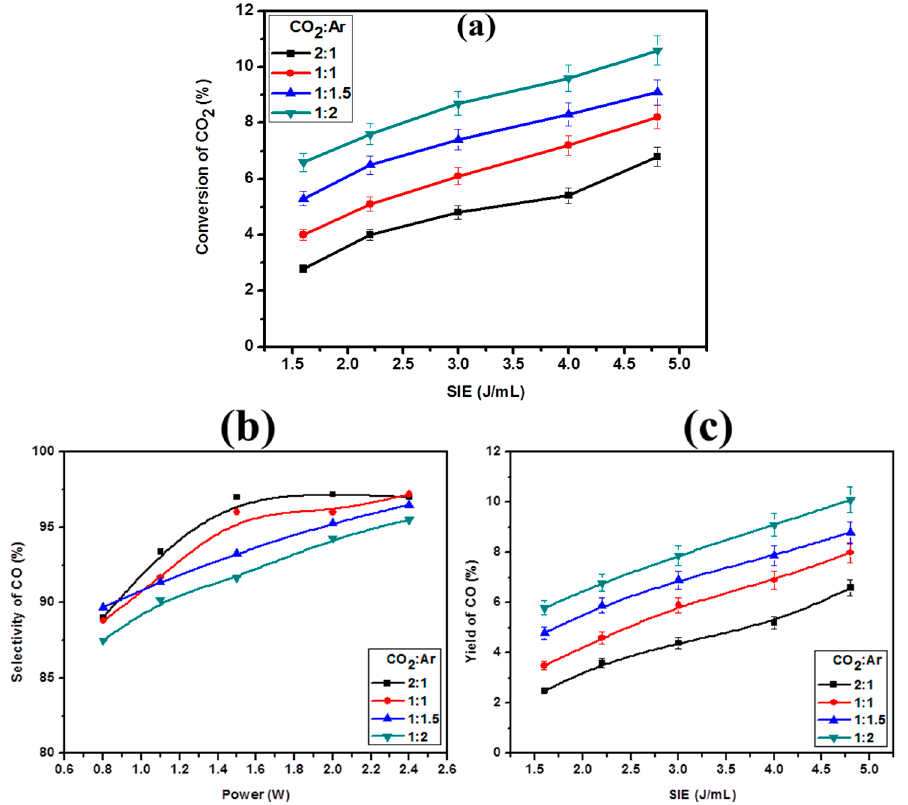
Figure 4. ( a ) CO 2 conversion with respect to SIE; ( b ) CO selectivity with respect to discharge power; ( c ) CO yield with respect to SIE. (Flow rate 30 mL/min, plasma frequency 50 Hz).